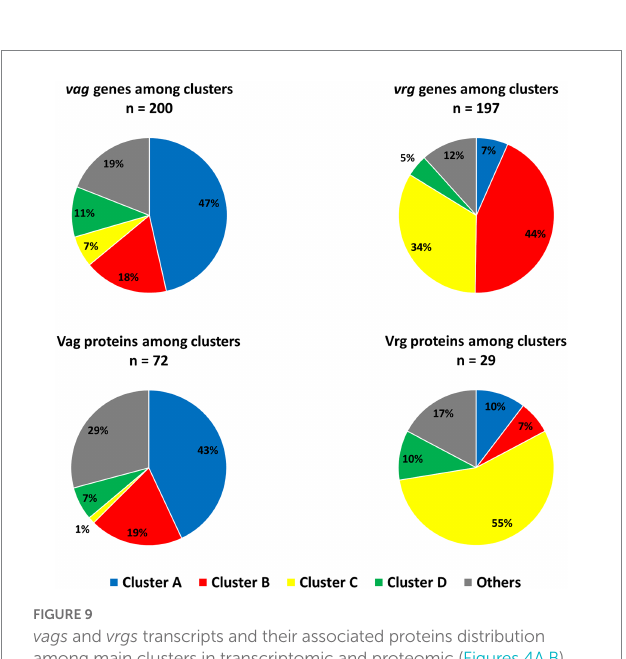
FIGURE 9 vags and vrgs transcripts and their associated proteins distribution among main clusters in transcriptomic and proteomic (Figures 4A,B) during Bordetella pertussis Tohama I culture. Based on 207 vags and 235 vrgs identified in recent studies (Moon et al., 2017; Coutte et al., 2020). “ n =” corresponds to the number of genes/proteins clustered in our data among vags or vrgs